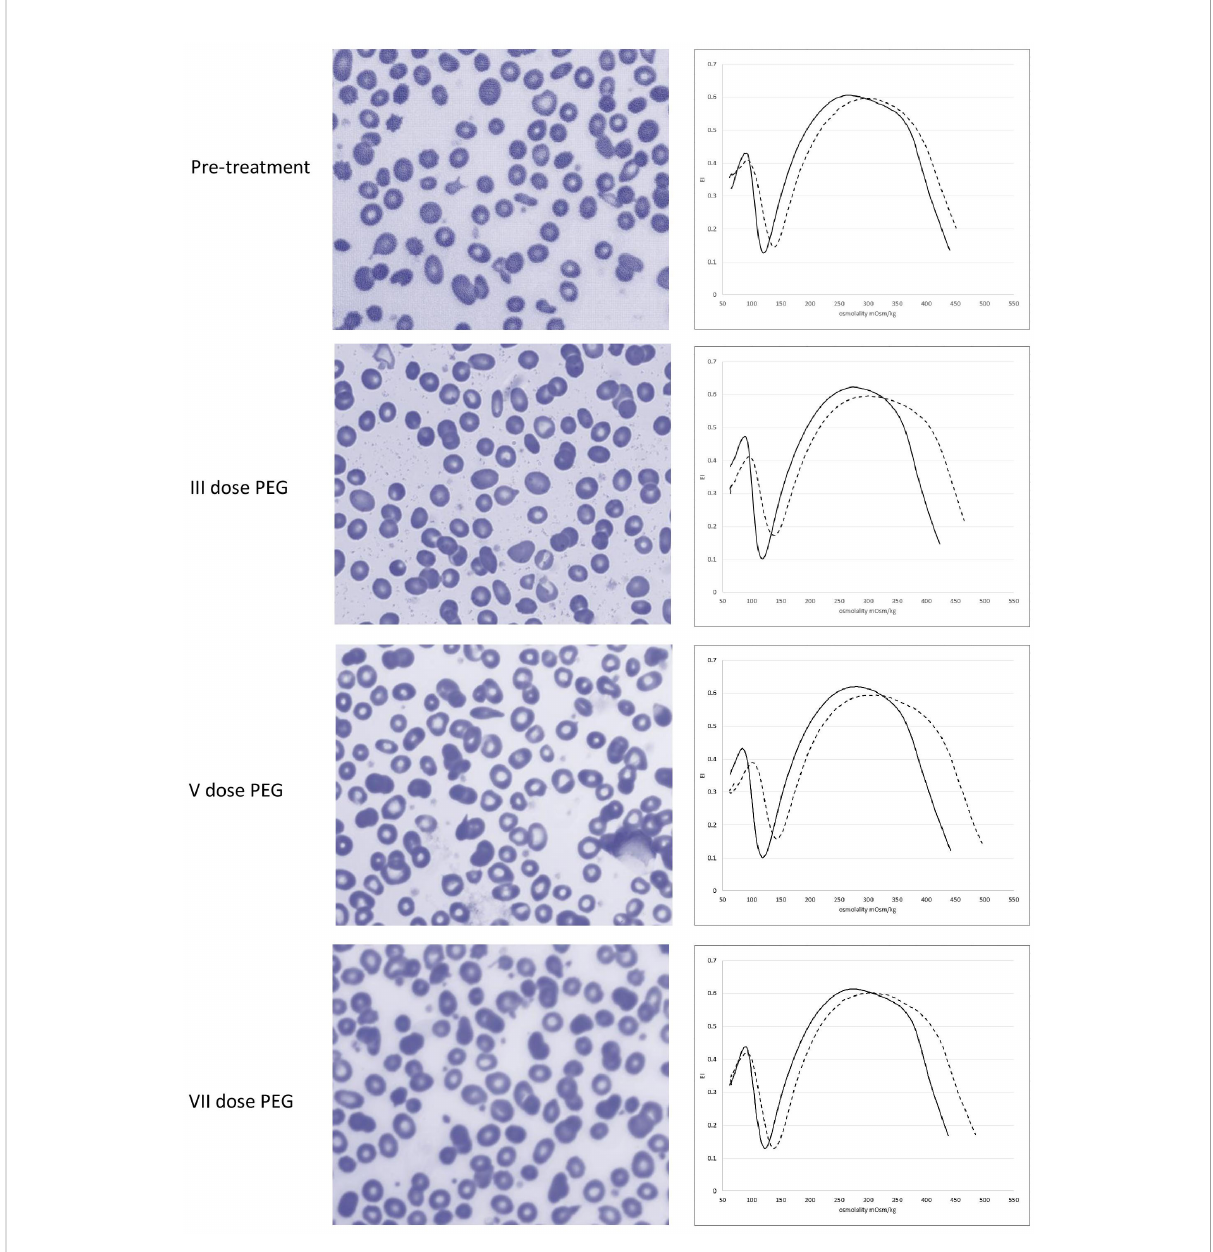
FIGURE 2 Erythrocyte morphology and ektacytometry before and after pegcetacoplan